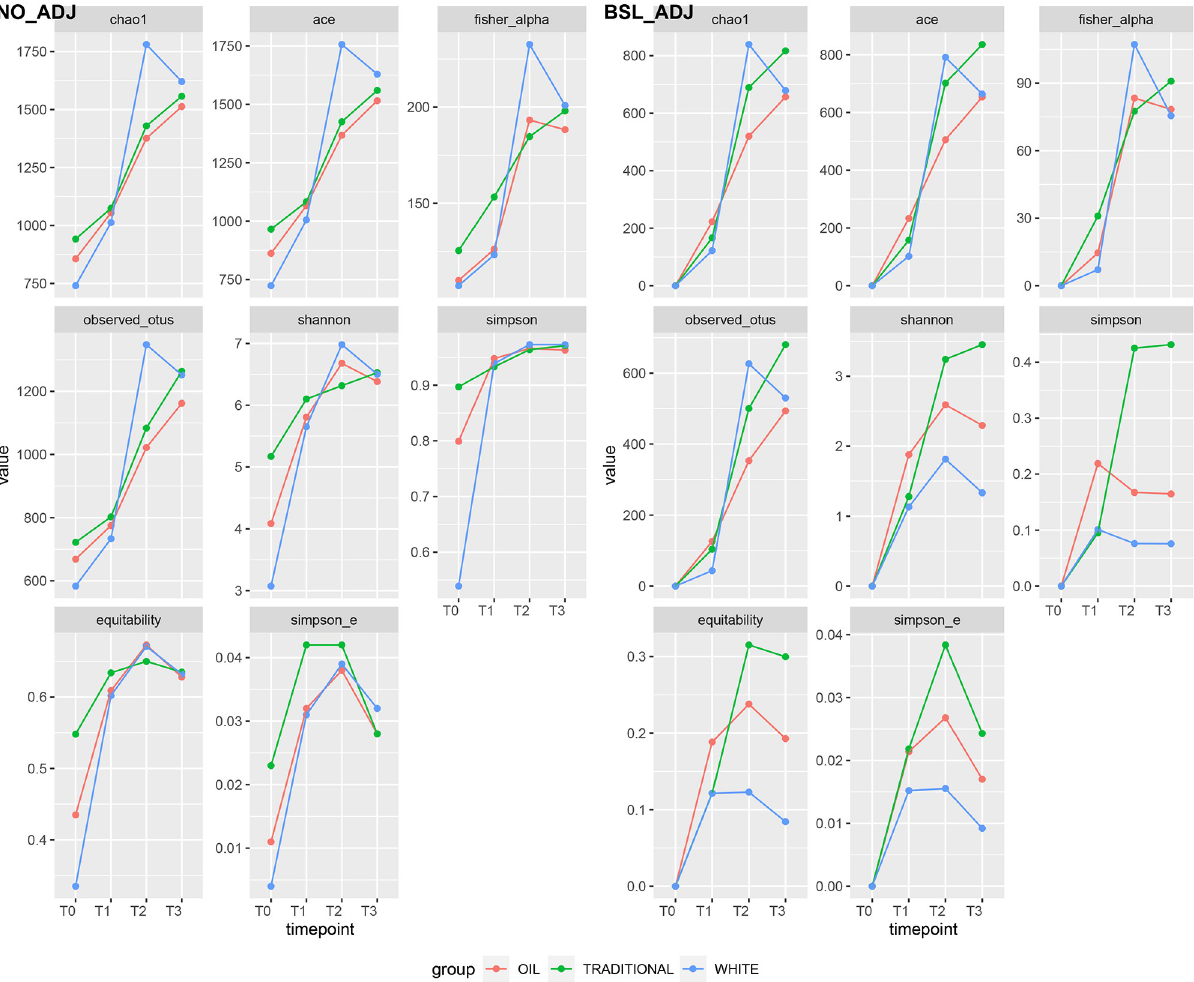
Fig 5. Alpha diversity. Average alpha diversity indices per group over timepoints. Non-adjusted (left) and baseline-adjusted (right) values.